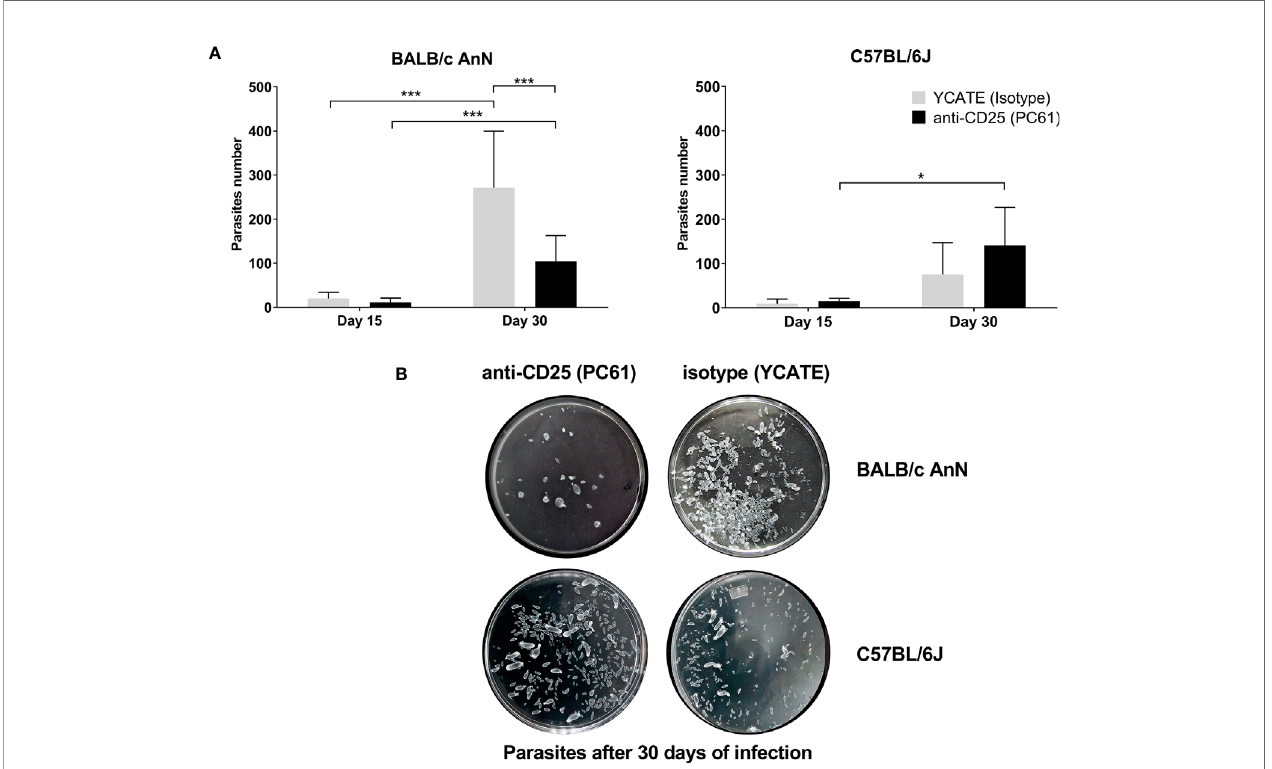
FIGURE 3 | Regulatory T cell depletion decreased parasite load in susceptible mice (BALB/cAnN). Mice treated with either anti-CD25 (PC61) or isotype (YCATE) were infected with Taenia crassiceps cysticerci. (A) Parasite load was determined in susceptible (BALB/cAnN) and non-susceptible (C57BL/6) mice. Six infected mice and 6 controls were included for each time (15 or 30 days), each condition (isotype or depleted), and each strain. Signi fi cant differences were determined by the U Mann- Whitney test. * P < 0.05, ** P < 0.01, *** P < 0.005. (B) Representative photograph of parasites recovered from one mouse of each strain on day 30